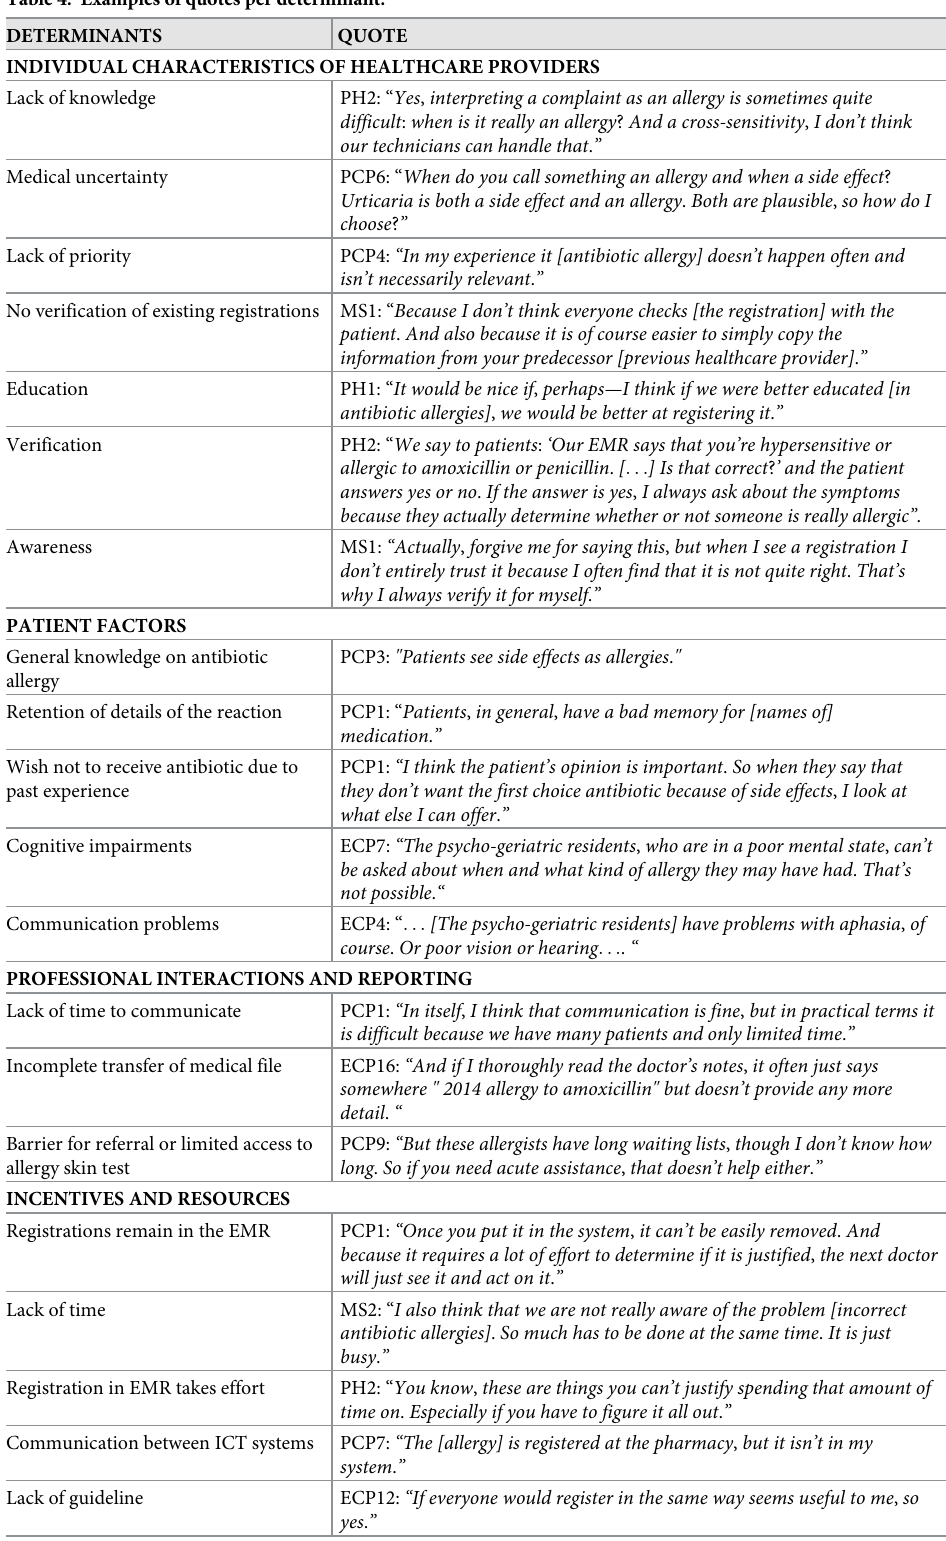
Table 4. Examples of quotes per